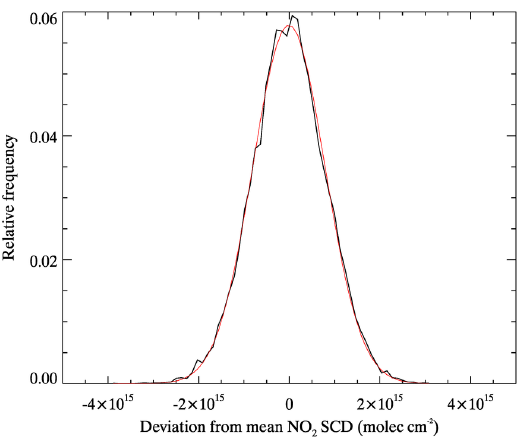
Figure 13. Time series of the monthly mean OMI NO 2 uncertainty between 2005 and 2008 calculated using the box-mean technique in Fig. 12. The dotted line represents the linear trend and seasonal cycle fitted using